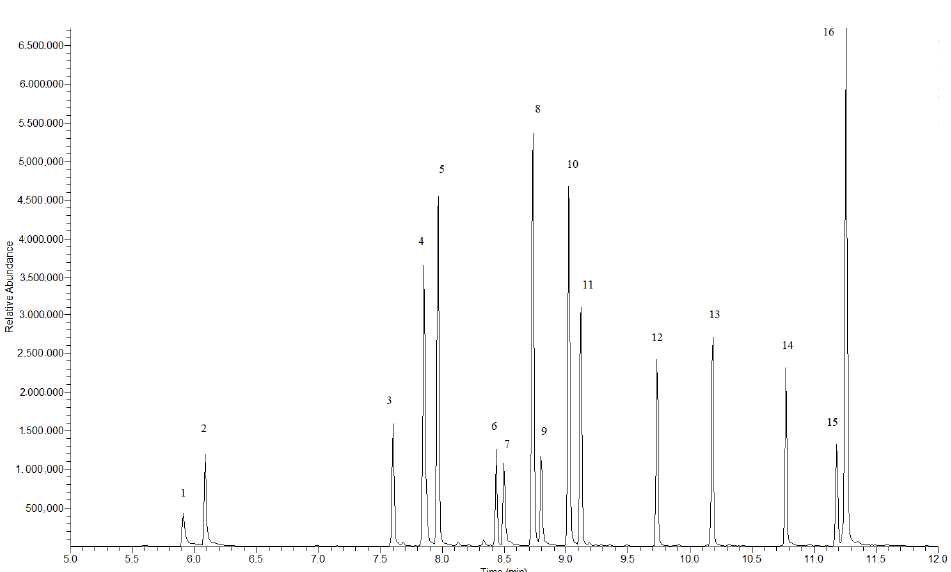
Figure 5. Total ions chromatogram of 16 kinds of synthetic cathinones with GC-MS. Peaks: (1) Cathinone; (2) MC; (3) 4-CEC; (4) 4-MPD; (5) NEH; (6) 4-CBC; (7) MDMC; (8) 4-MePPP; (9) MDEC; (10) 4-Cl- α -PPP; (11) 4-F- α -PHP; (12) 4-Cl- α -PVP; (13) 4-Cl- α -PHP; (14) MDPV; (15) MDPHP; (16) TH-PHP.